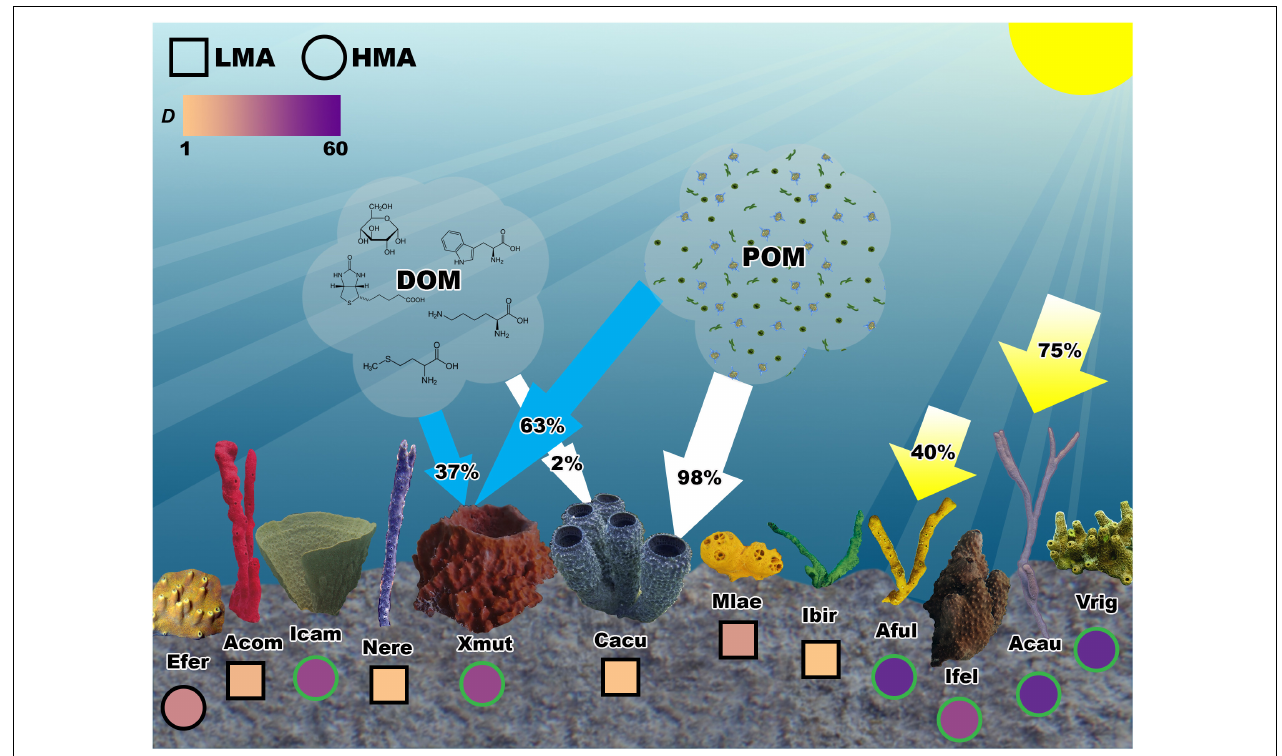
FIGURE 2 | Conceptual model of 12 common sympatric sponge species in the Caribbean Sea. Caribbean sponges possess a diversity of morphologies and microbial symbioses that have helped them adopt novel strategies for obtaining nutrition from a variety of sources including particulate organic matter (POM), dissolved organic matter (DOM), and solar irradiance (yellow arrows). Relative average reliance on DOM and POM carbon sources is denoted with arrows from these clouds to two species Xestospongia muta (Xmut) and Callyspongia aculeata (Cacu) derived from McMurray et al. (2018). Relative reliance on carbon from photosymbionts is derived from Freeman and Thacker (2011). Continuous diversity values for the inverse Simpson’s Index ( D ) are represented by a color gradient in circles (HMA sponges) and squares (LMA sponges) below each sponge. Sponges that host abundant photosymbionts are denoted by a green outline of the circles or squares representing D